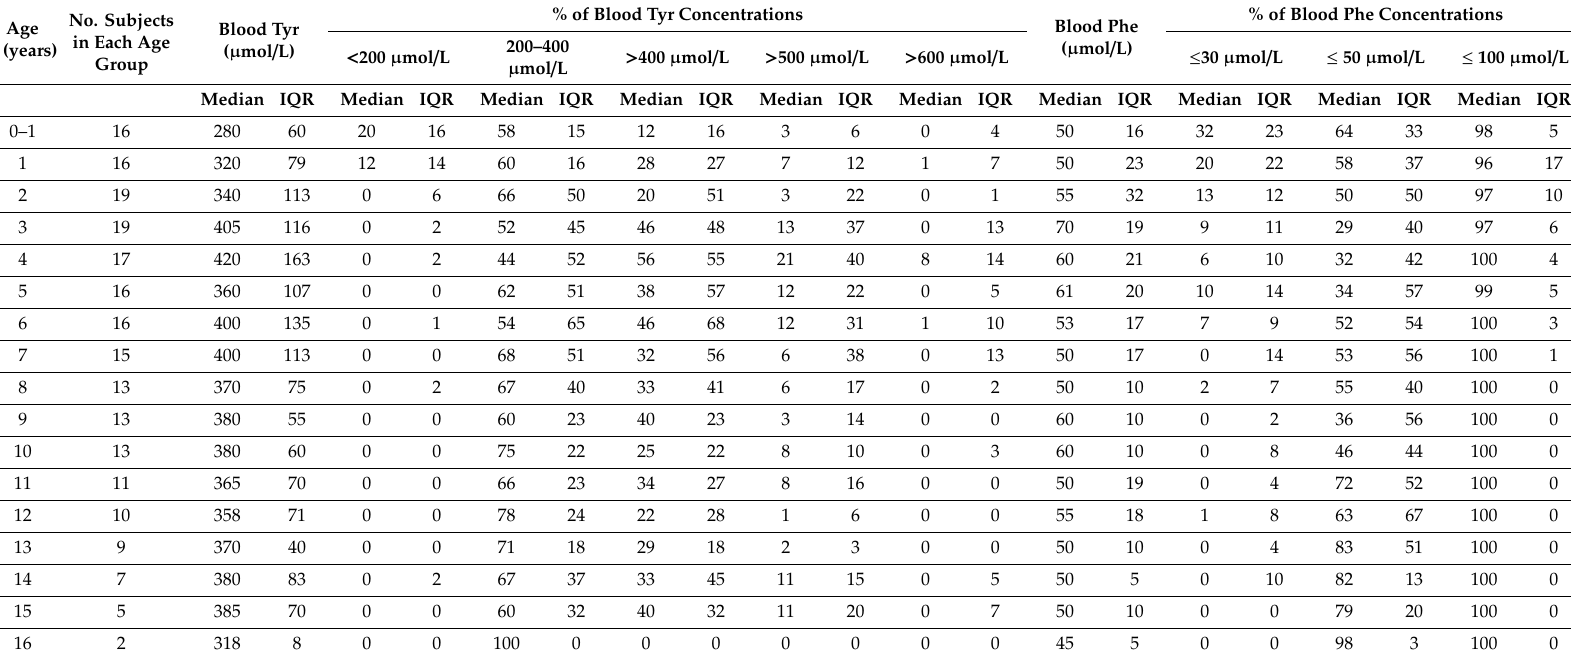
Table 3. Median blood Tyr and Phe concentrations by age in patients with